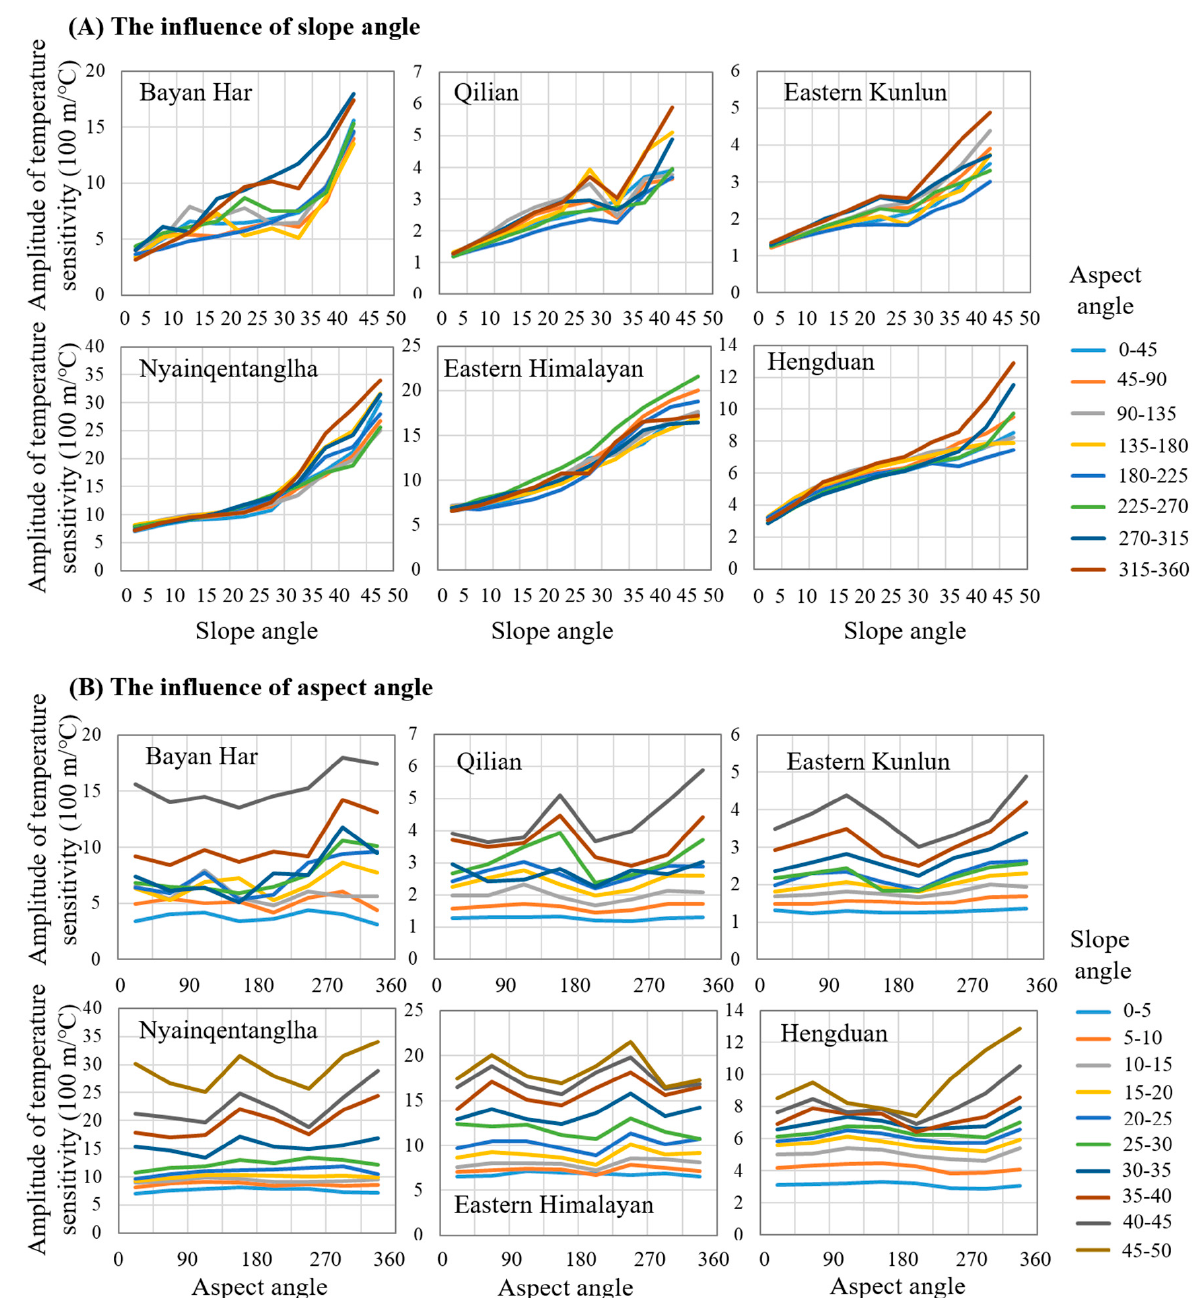
Figure 11. The influence of ( A ) slope angle and ( B ) aspect angle on the amplitude of temperature sensitivity in the six mountainous regions. Slopes and aspects were sampled at the interval of 5° and 45°, respectively.